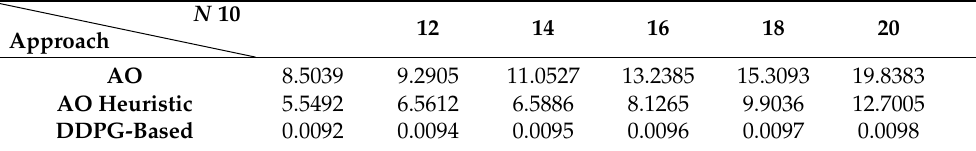
Table 4. Average prediction run time (seconds) for different numbers of reflecting elements in dynamic UE